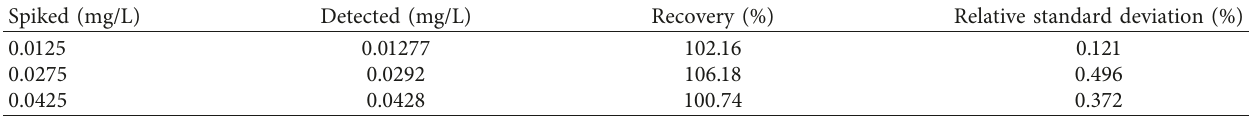
Table 1: Predicted results of aspartame in purified water ( n �